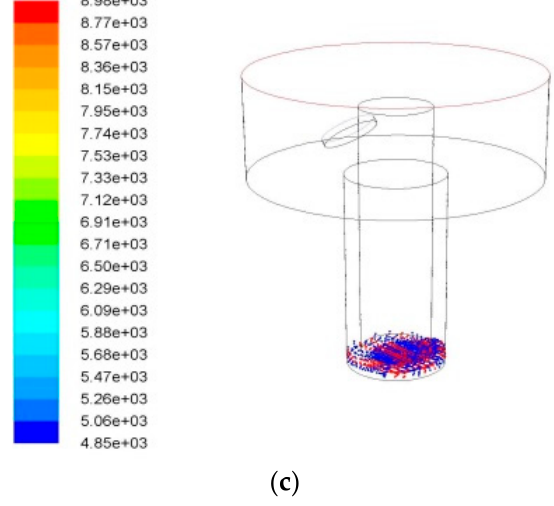
Figure 4. Machining without ultrasonic vibration. ( a ) Velocity field; ( b ) Pressure field; and ( c ) Debris distribution.